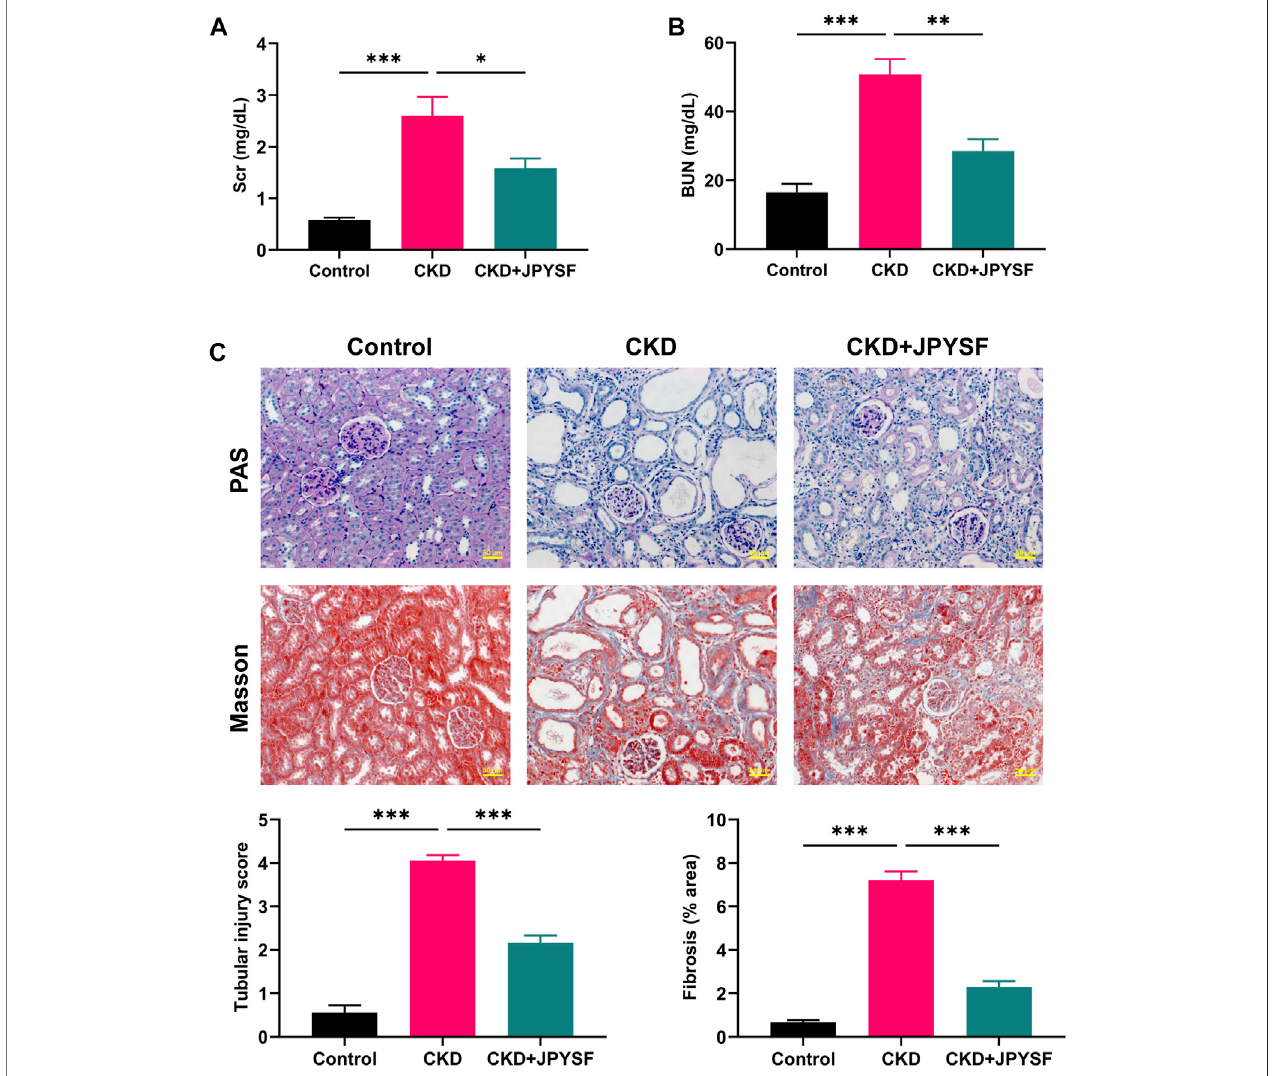
FIGURE 1 | Effects ofJPYSF on renal function and pathological injury in adenine-induced CKD rats. (A) Serum creatinine levels. (B) Blood urea nitrogen levels. (C) RepresentativePASandMassonstainingimagesandquantitativeanalysisoftubularinjuryand fi brosis.Allimagesareshownatidenticalmagni fi cation,×200,scalebar= 50 μ m. Values are expressed as mean ± SEM, n = 6 rats per group (* p < 0.05, ** p < 0.01, and *** p < 0.001 between the indicated two groups).